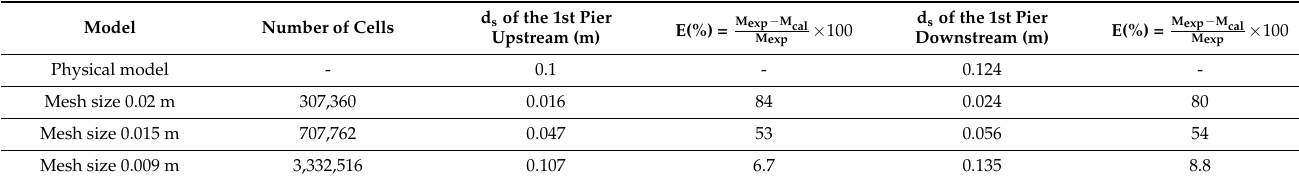
Table 2. Comparison of the numerical results for different mesh cell sizes with the laboratory results.